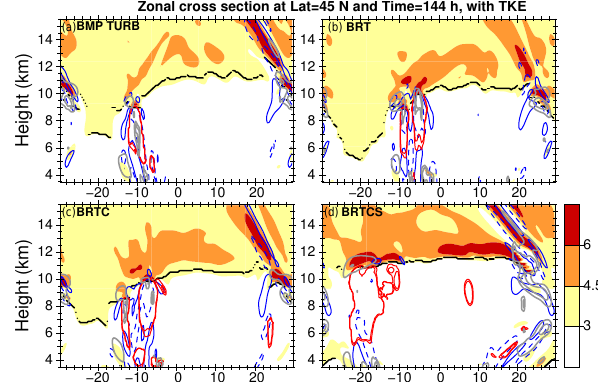
−20 −10 Figure 14. Zonal cross sections along 45 ◦ N of static stability N 2 (in 10 − 4 s − 2 ) after 144h of model integration. Solid blue lines show regions with positive values of the vertical divergence ∂w/∂z (for 5.0 × 10 − 5 s − 1 , 50.0 × 10 − 5 s − 1 ), dashed blue lines show negative values (for − 5.0 × 10 − 5 s − 1 , 50.0 × 10 − 5 s − 1 ). Red lines show specific cloud-ice content q i (for 5.0 × 10 − 6 kgkg − 1 , 10 × 10 − 6 kgkg − 1 ). Gray lines show turbulent kinetic energy (TKE) (in 0.5, 1.0, 5.0m 2 s − 2 ). The four panels show (a) BMP TURB, (b) BRT, (c) BRTC, and (d)